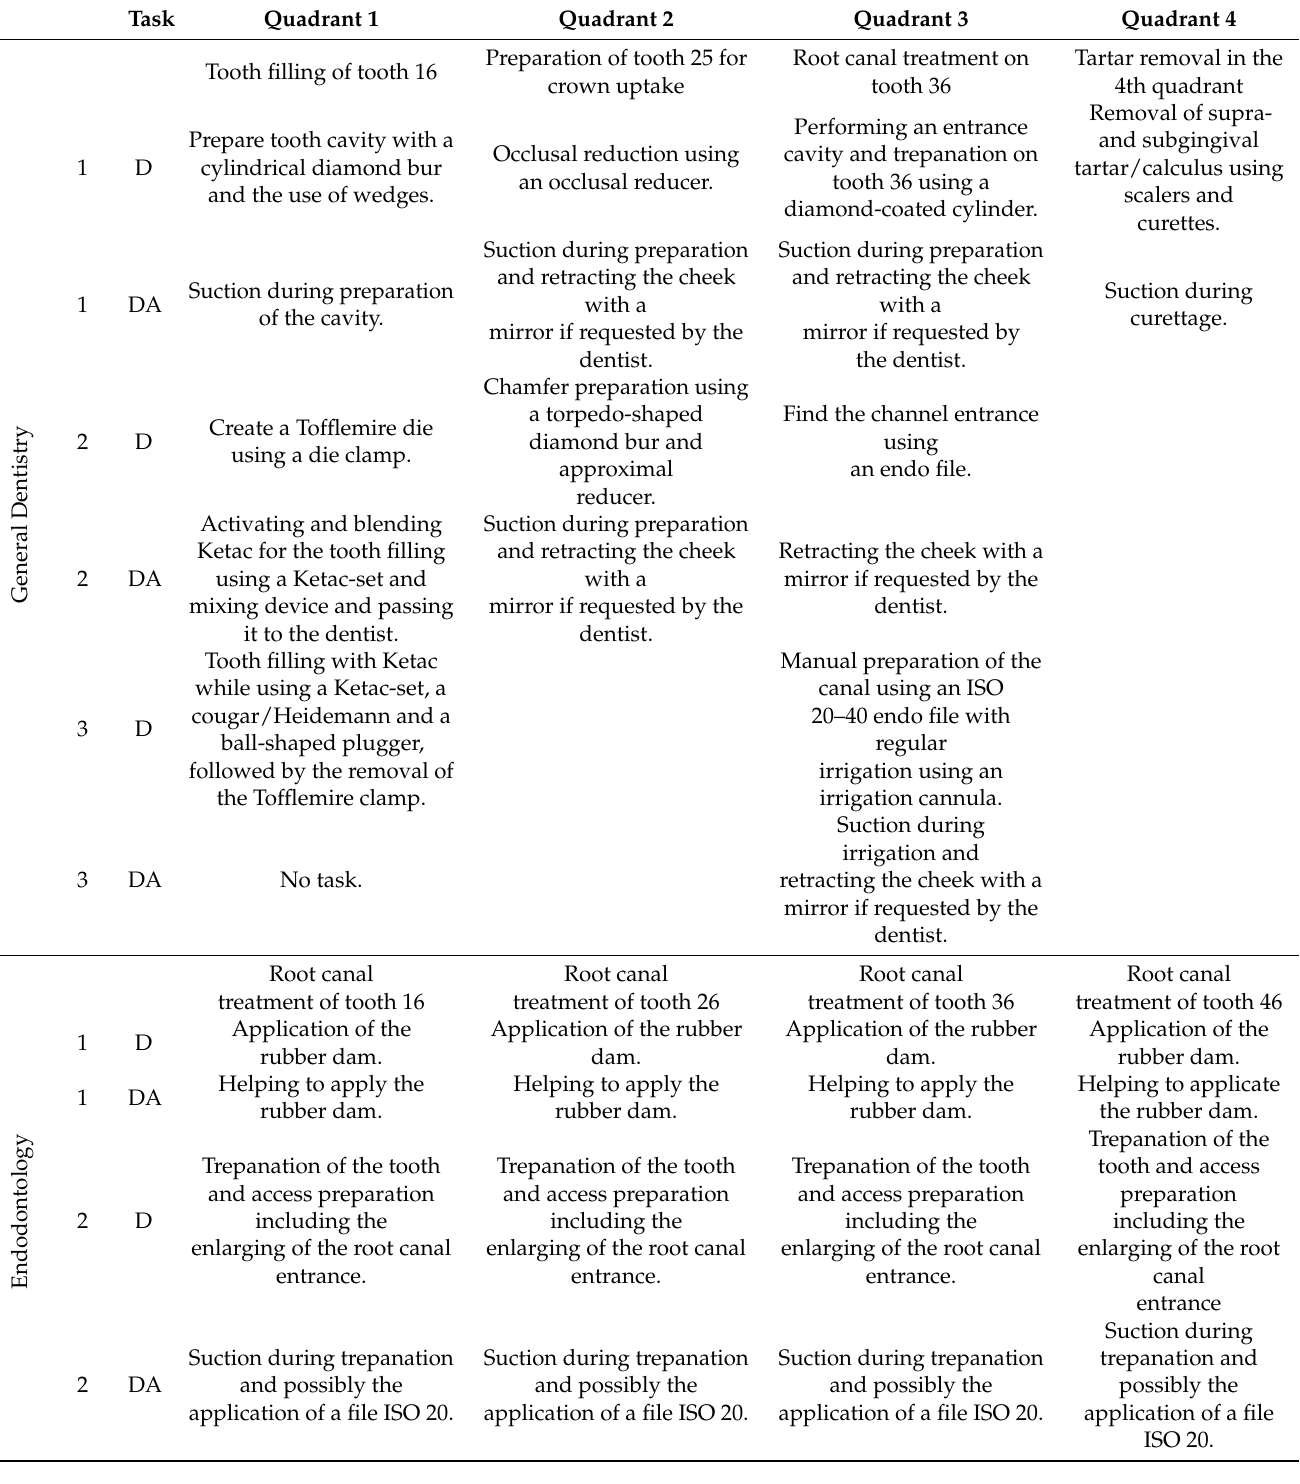
Table 2. Dental tasks of the fields of specialization. More detailed information can be found in Ohlendorf et al.